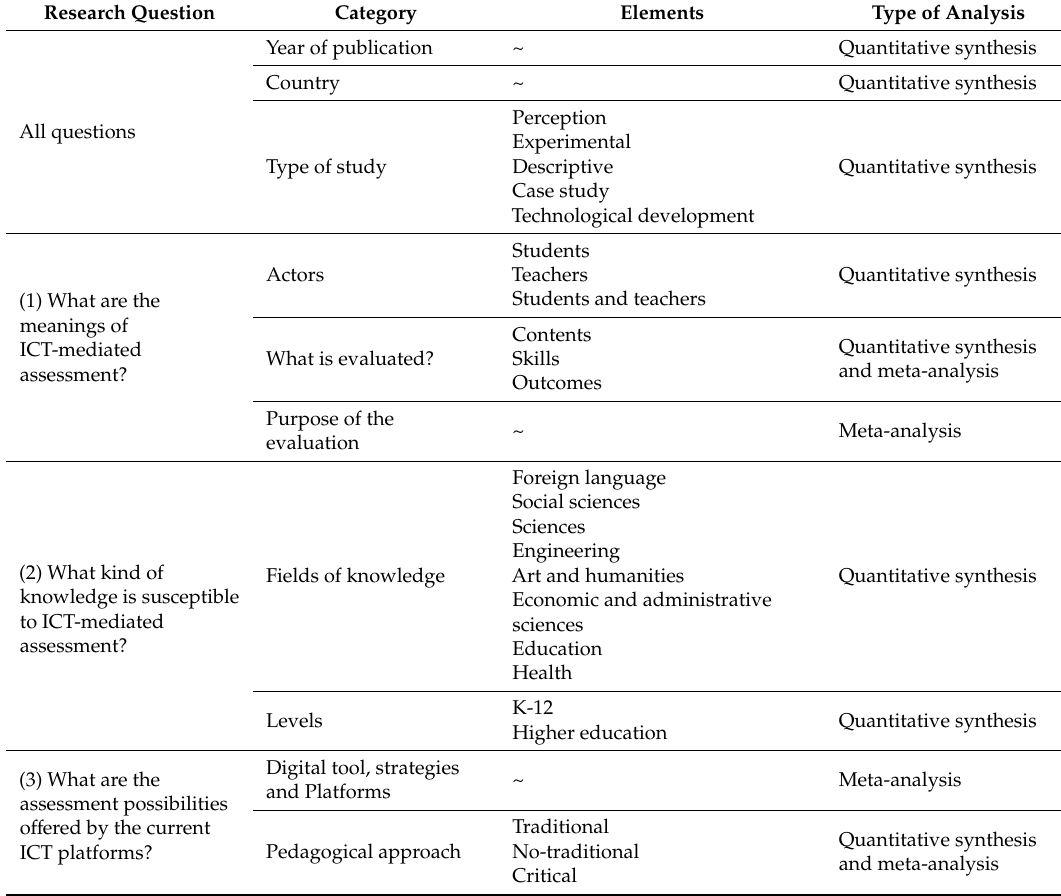
Table 2. Categories and research questions for the systematic review of ICT-mediated assessment.